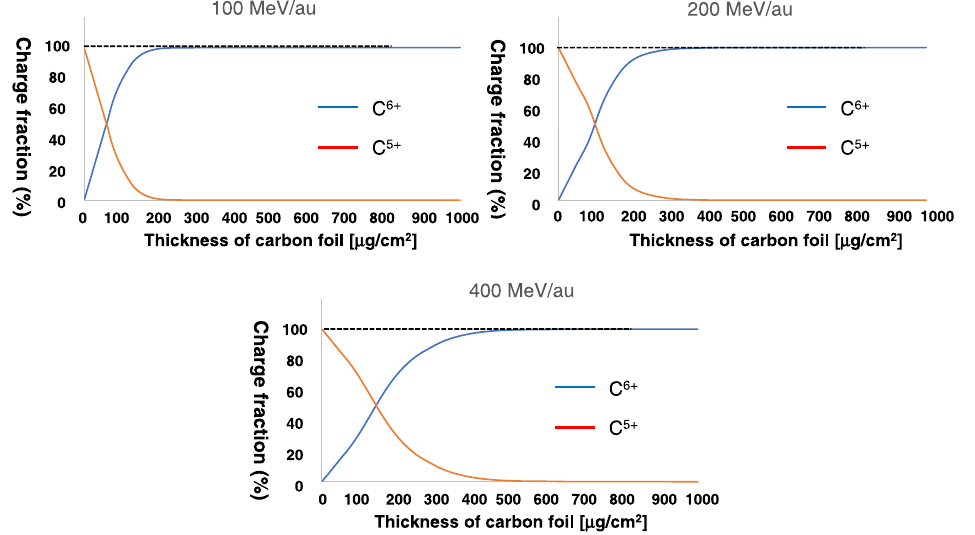
FIG. 9. Charge conversion efficiency for C 5 þ of 100, 200, and 400 MeV = au.